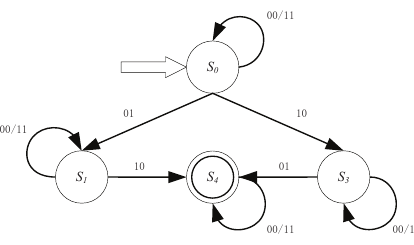
Figure 5. A Deterministic Finite Automaton for r p (cid:54) = r q